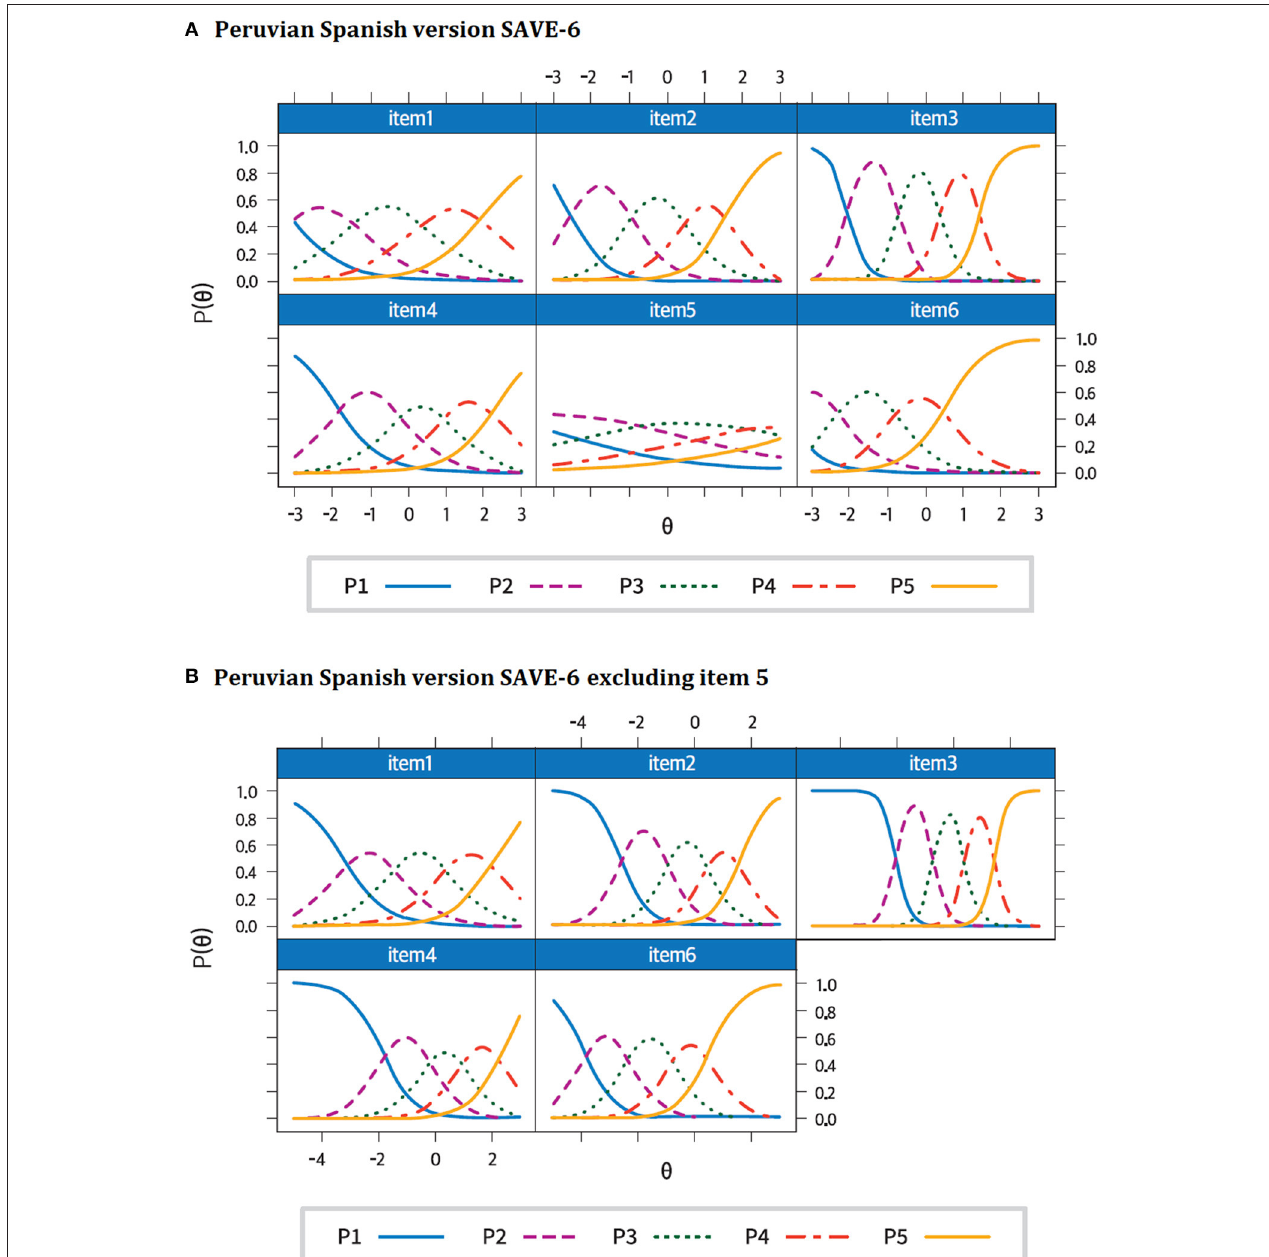
FIGURE 1 | Threshold characteristics curves of the Peruvian Spanish versions of SAVE-6 (A) and SAVE-6 excluding item 5 (B) . SAVE-6, Stress and Anxiety to Viral Epidemics-6